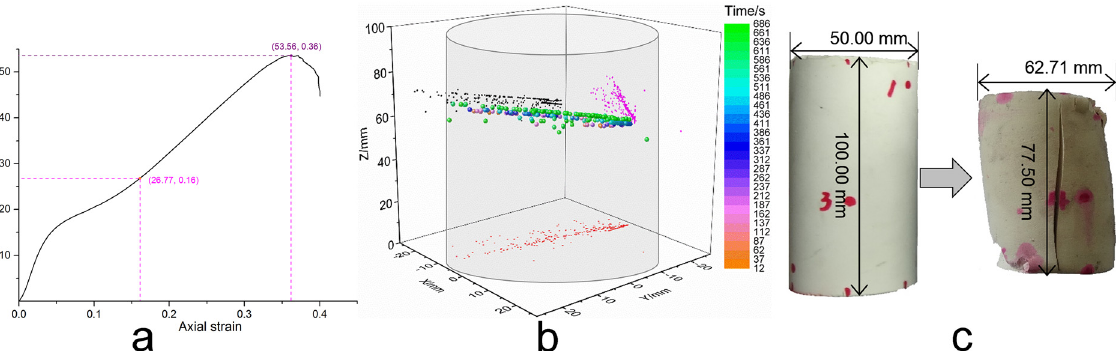
Fig 10. Test results of MEYCO 364. (a) Relationship between the axial strain and axial stress. (b) Damage source location based on AE detection. (c) Scale change before and after the uniaxial compression